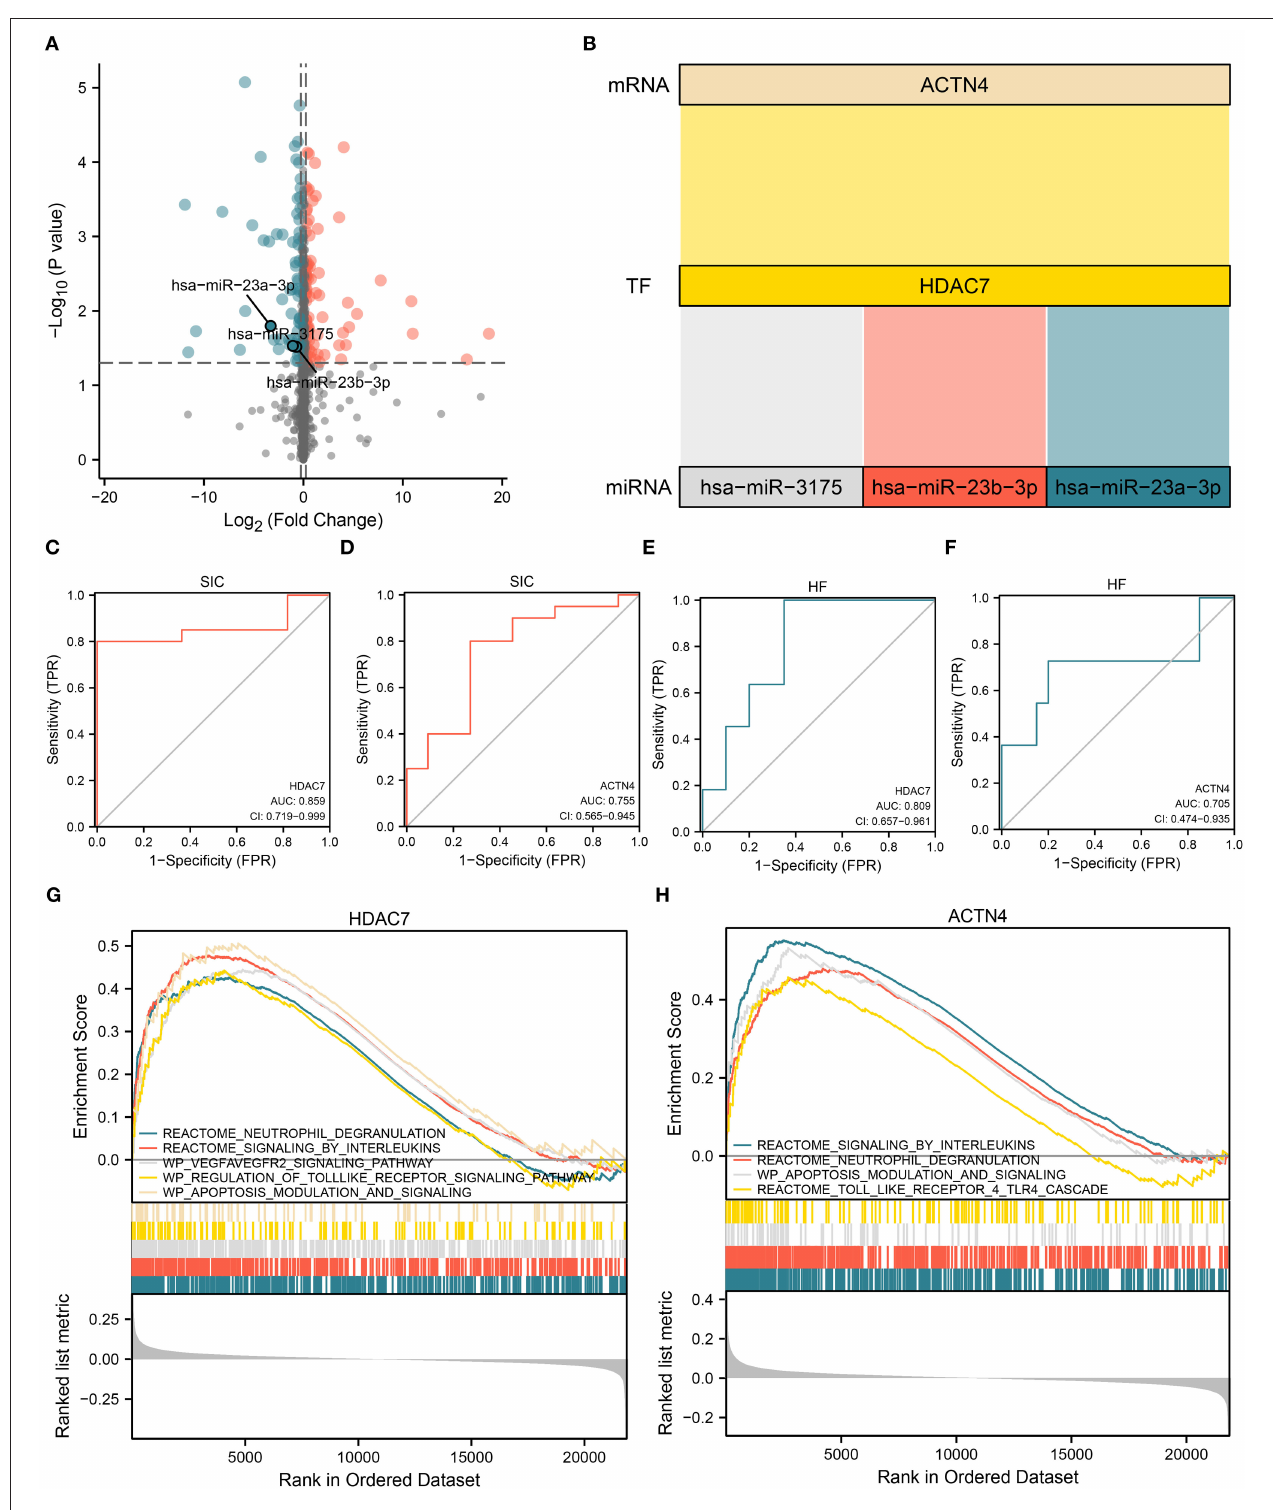
FIGURE 6 | Establishment of the miRNA/TF/mRNA axis and gene set enrichment analysis (GSEA). (A) Volcano plot showing the differential expression of miRNAs that regulate TF in molecular interaction networks. (B) Sankey diagram showing the core miRNA/TF/mRNA regulatory axis. (C,D) ROC curves showing the ability of (C) HDAC7 (AUC:0.859) and (D) ACTN4 (AUC:0.755) to distinguish between SIC and HC. (E,F) ROC curves showing the ability of (E) HDAC7 (AUC:0.809) and (F) ACTN4 (AUC:0.705) to distinguish between HF and HC. (G,H) GSEA results for (G) HDAC7 and (H) ACTN4.